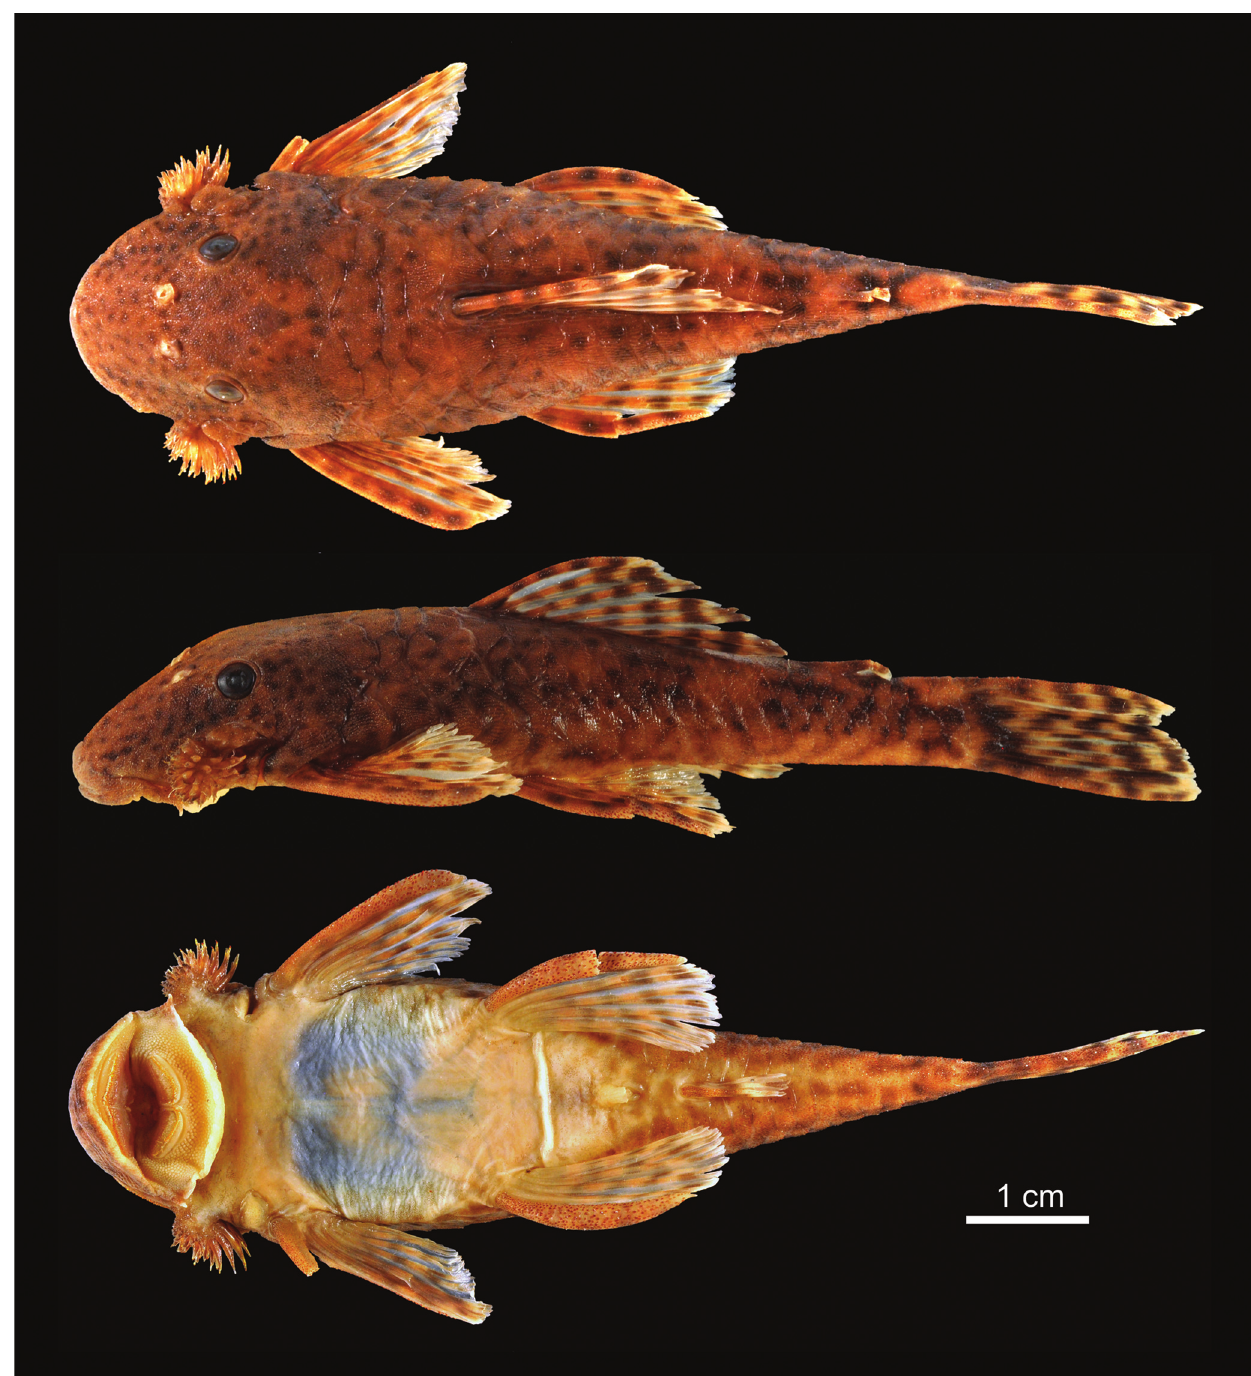
Fig. 4. Dorsal, lateral, and ventral views of Neblinichthys peniculatus , female, paratypes, AMNH 91020, 78.8 mm SL.